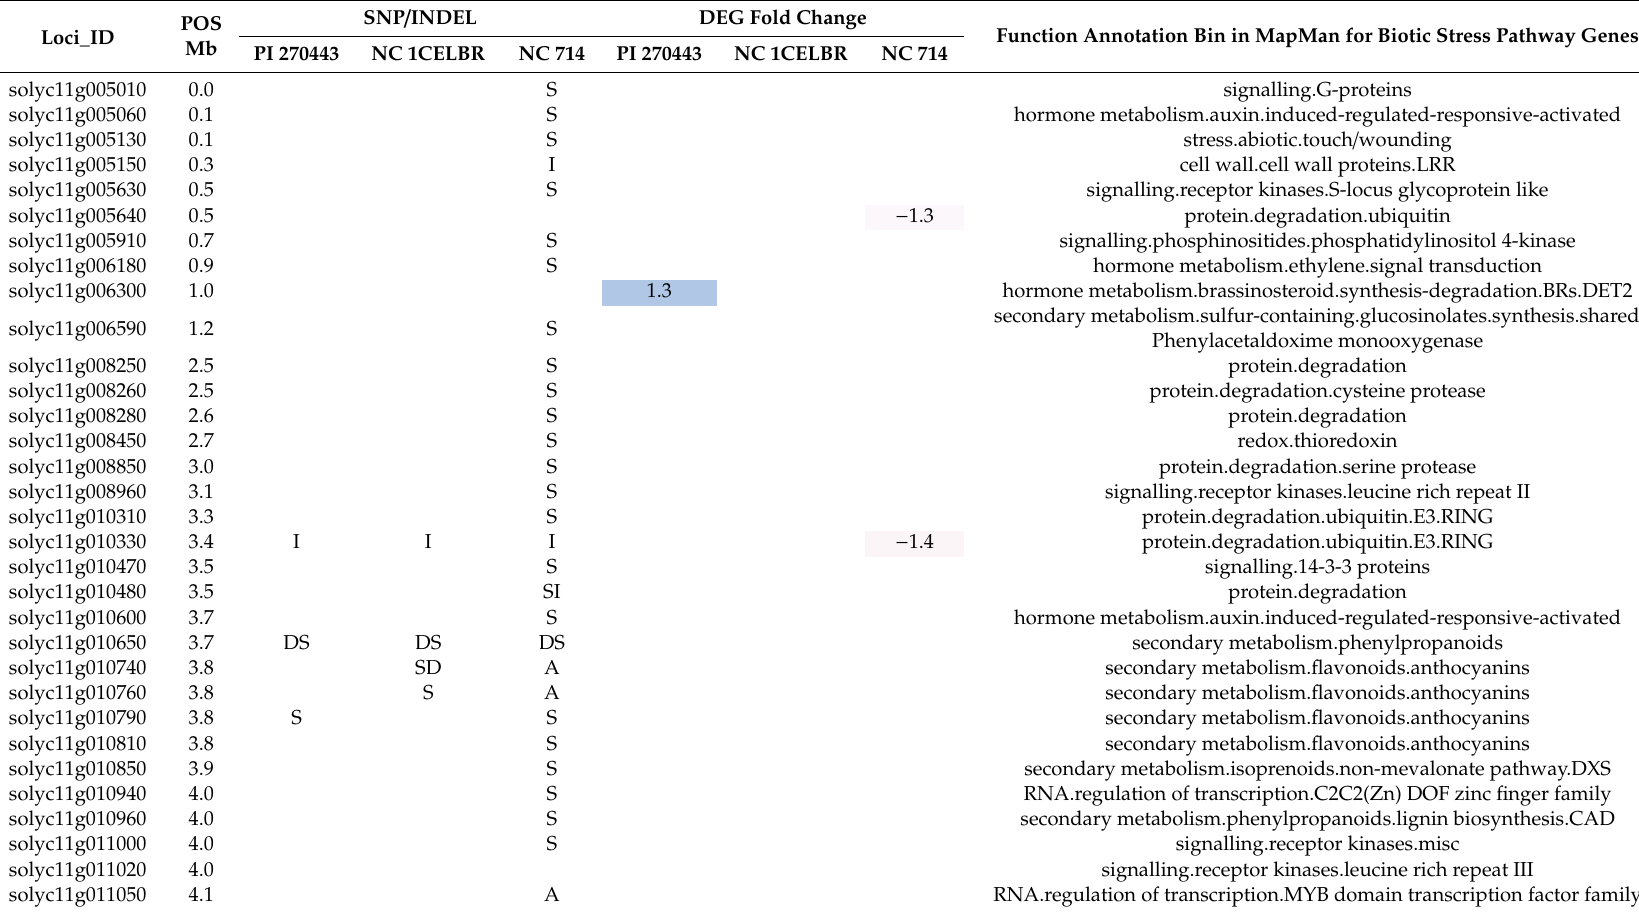
Table 6. Biotic stress pathway DEGs or genes with SNP / INDELs on chr11 in position (POS) listed as Million base (Mb). In the section of SNP / INDELs, “S”, “I”, and “D” represent sequence variation in the homo form of SNP, INSERT, and DELETION alternative form against the reference genome of Heinz 1706. The DEG fold changes are log 2 of gene expression change induced by BS inoculation (IN / CK). Gene functions annotation bin were annotated by MapMan package in this study. DEG fold change background color intensity corresponds to the level of